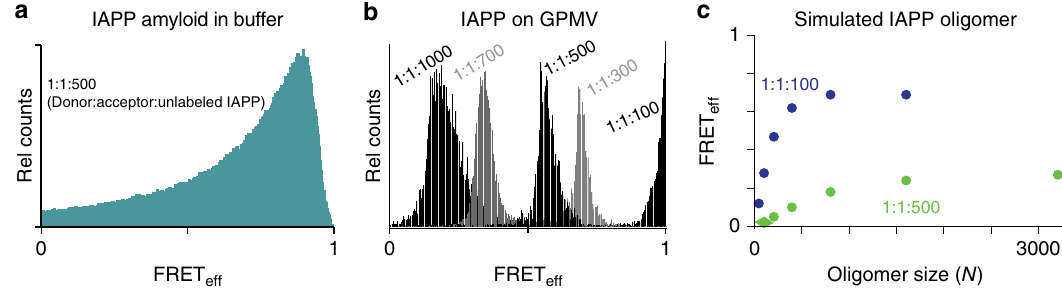
Fig. 6 Observed and expected behaviour for diluted FRET in oligomers of IAPP. a Canonical amyloid fi bres were prepared by dilution of a stock solution of IAPP into aqueous buffer. Stock solution contained a mixture of IAPP A488 (donor), IAPP A647 (acceptor) and unlabelled IAPP at 1:1:500. Confocal imaging was used to prepare a FRET eff histogram (green). b Intermolecular FRET between IAPP A488 (donor) and IAPP A647 (acceptor) detected on GPMVs at the indicated ratios of donor:acceptor:unlabelled protein. Each condition contains a protein equivalent of ADM-116 to maintain a stable conformation (Fig. 7a, c). Each distribution represents the sum of observations taken from at least three different GPMVs. c Simulated average FRET eff for a dynamic, isotropic spherical distribution of an oligomer composed of N copies of IAPP. Relevant simulation constants are volume per IAPP (4000 Å 3 ), Förster distance (52 Å) and the indicated ratio of (donor labelled IAPP):(acceptor labelled IAPP):(unlabelled